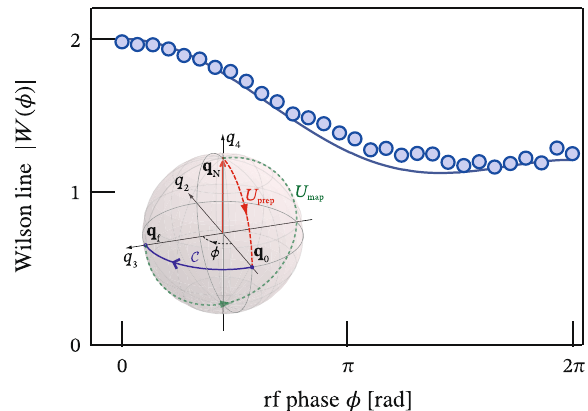
Fig. 5 Wilson line. Absolute values of measured Wilson line ∣ W ( ϕ ) ∣ for open paths with variable path length characterized by rf phase range ϕ . The theory curve (solid line) is also shown. The inset illustrates the control sequence for Wilson line measurement of a segment from q 0 to q f on a circular loop. After preparing one of the eigenstates at q 0 , the rf phase ϕ A is ramped from 0 to ϕ . The red and green curves represent the pulse controls for the state preparation and the state mapping for the read-out. The laboratory parameters are Ω A = Ω B = h × 1.4 kHz.